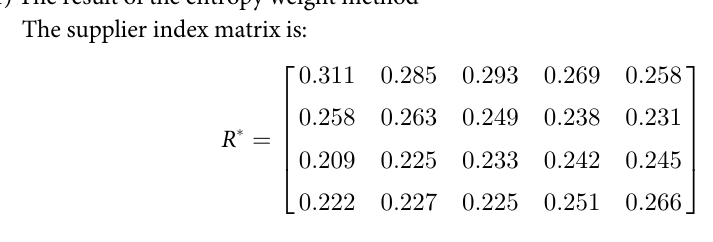
Table 7 describes the daily requirements for emergency supplies of food. Everyone’s food consumption takes 300g as the minimum food demand and 500g as the highest daily demand.